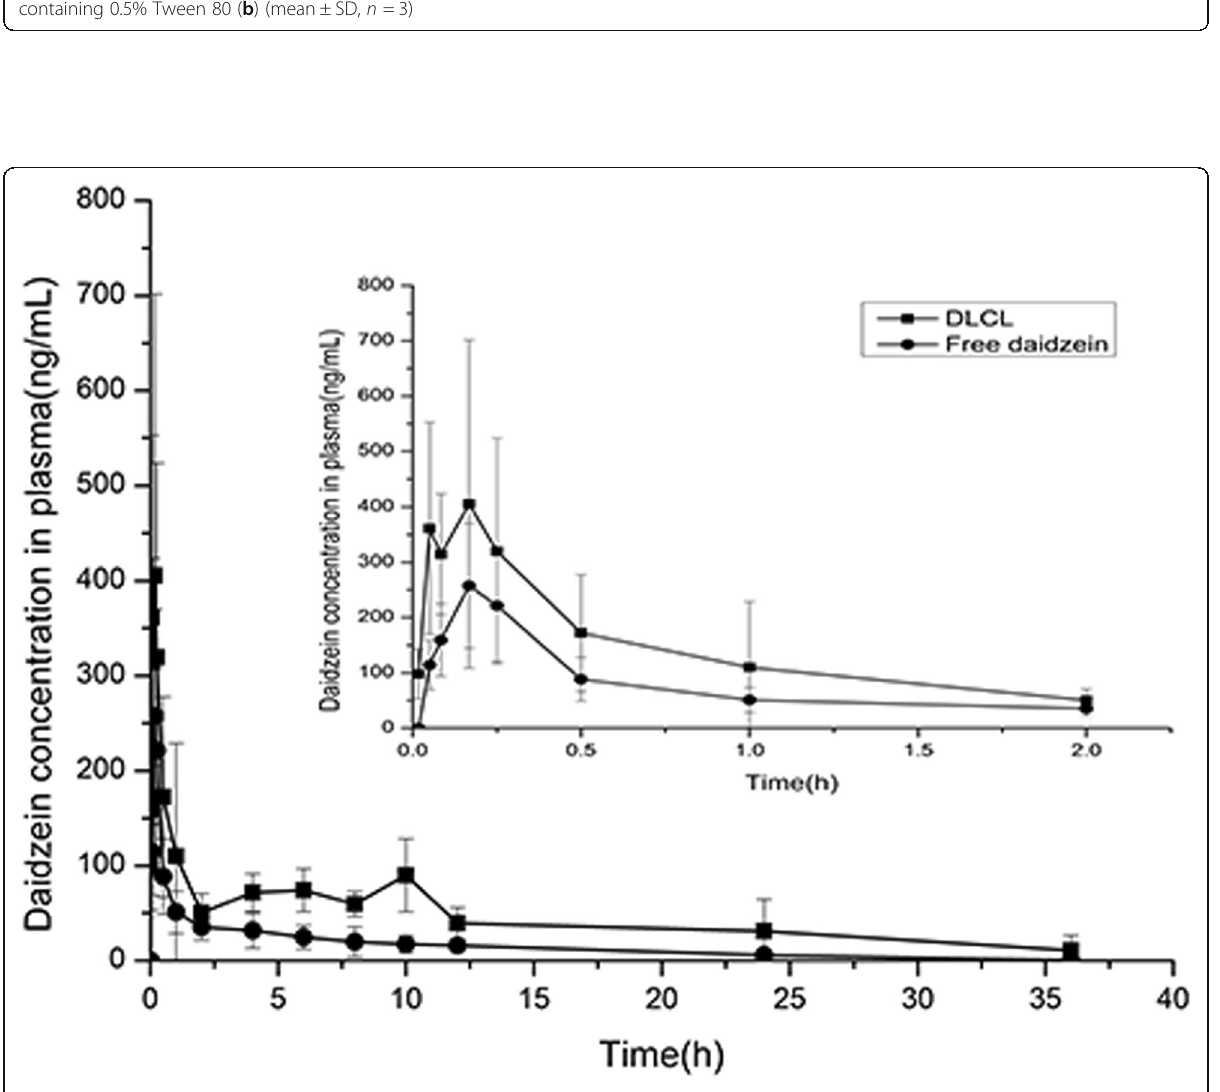
Fig. 6 Mean plasma concentration-time curves of DLCL and free daidzein after oral administration of a single dose of daidzein (30 mg/kg) (mean ± SD, n =